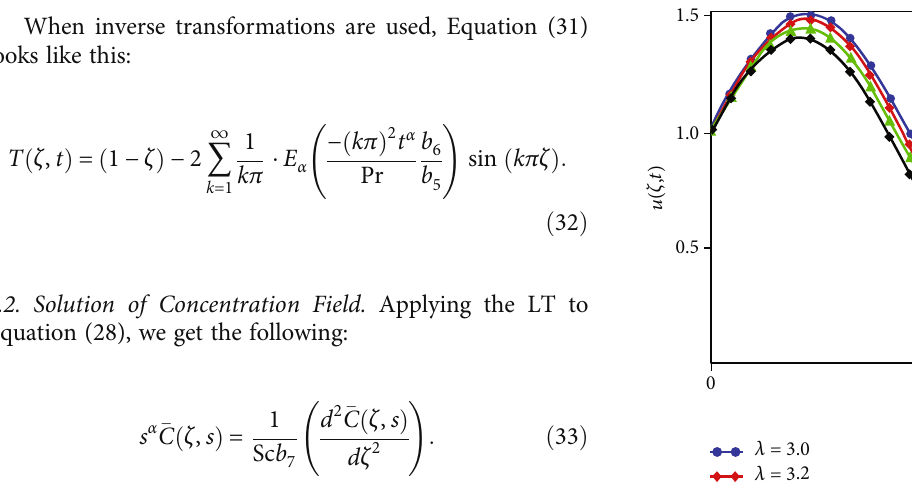
Figure 7: Impact of di ff erent values of λ on velocity pro fi le.